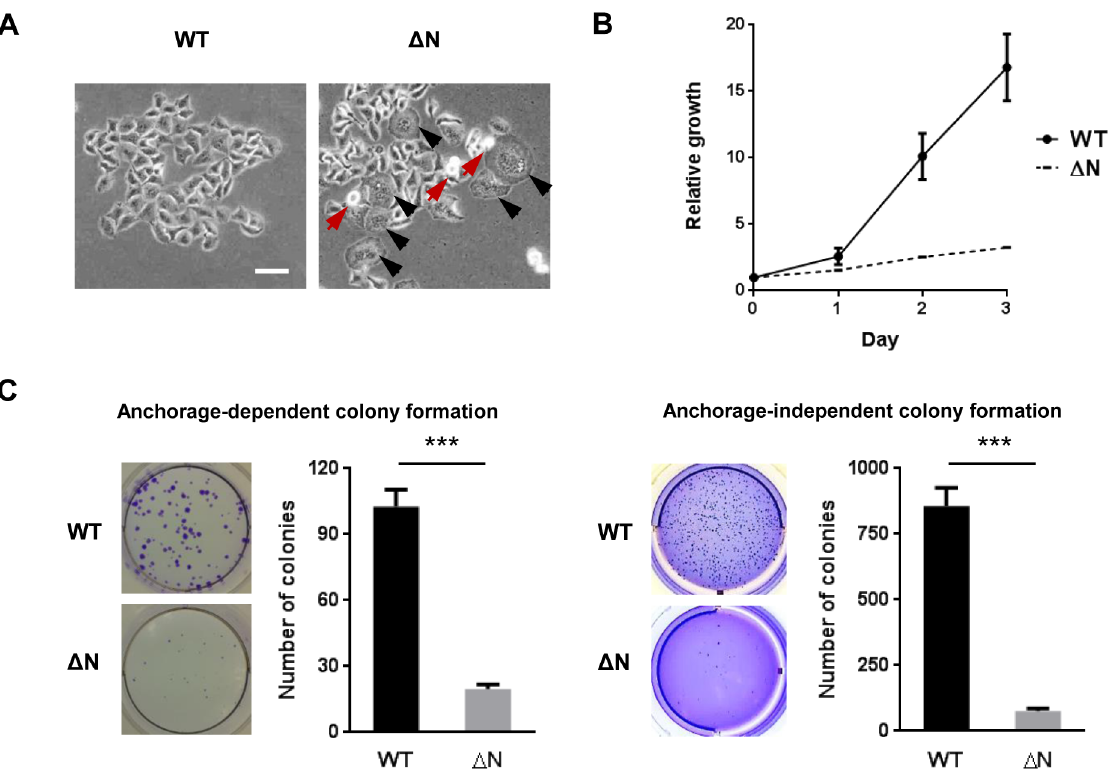
Figure 3. The hARD1 NLS mutant suppresses cell proliferation. A . Constitutive expression of the NLS mutant of hARD1 leads to morphological alterations. HeLa cells transfected with hARD1 WT and D N were cultured in DMEM containing G418 to select for stable clones. After establishment, cell images were observed by phase-contrast microscopy. Arrows indicate cells with altered morphology (black, enlarged; red, rounded). Scale bar, 50 m m. B and C . hARD1 D N-expressing cells showed a marked decrease in cell growth. B, cell growth of hARD1 WT and D N stable cell lines was monitored over time by MTS assay. The results are normalized to 0 day of each group and presented as mean 6 S.D. (n=5). C, HeLa cells stably expressing hARD1 WT and D N were subjected to anchorage-dependent (left) and -independent (right) colony formation assays. Number of colonies were presented as mean 6 S.D. with representative well pictures. N=3, *** P , 0.005.